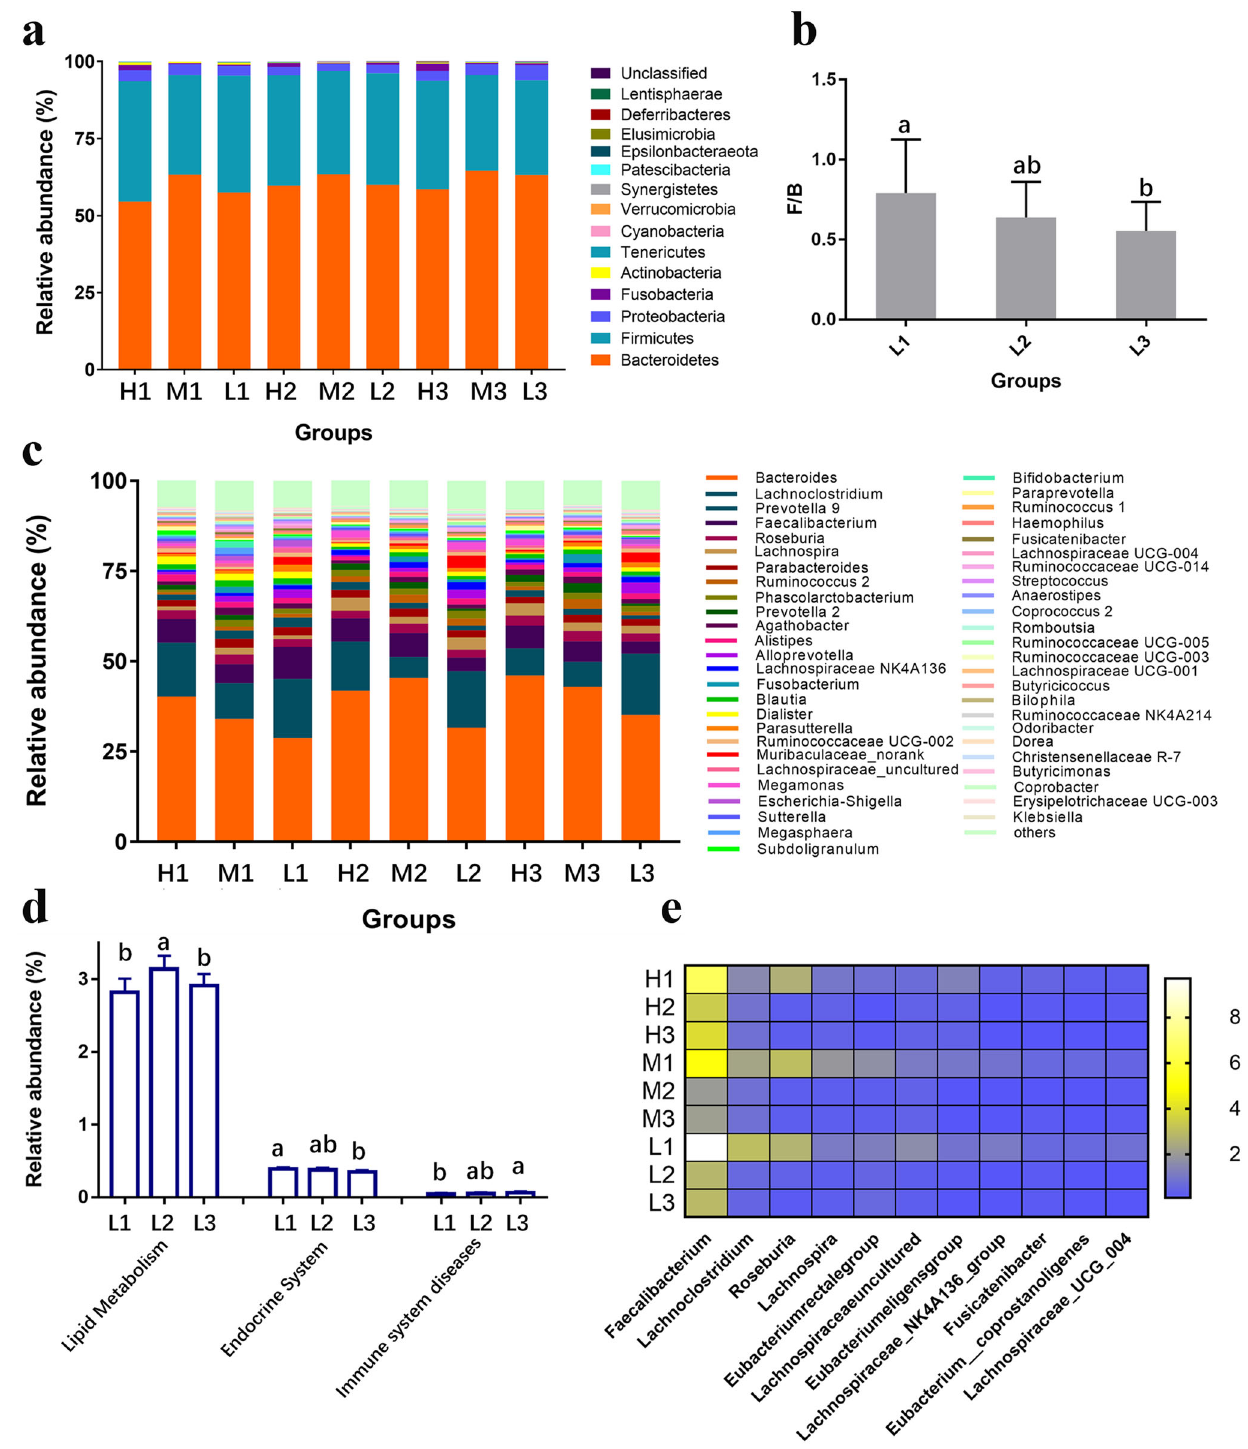
Fig. 2 Changes in the composition and potential function of the fecal microbiota in response to meat-based diets or digests of meat proteins. a The microbiota at the phylum level, ( b ) the Firmicutes/Bacteroides (F/B) ratio in the low-BMI volunteers, ( c ) the microbiota composition at the genus level; d the differential functions of microbial genes; and ( e ) the differential genera in response to digests of meat proteins in vitro (the top 50 genera are shown), the color scale indicates the relative abundance (%) of genera. Error bars represent standard